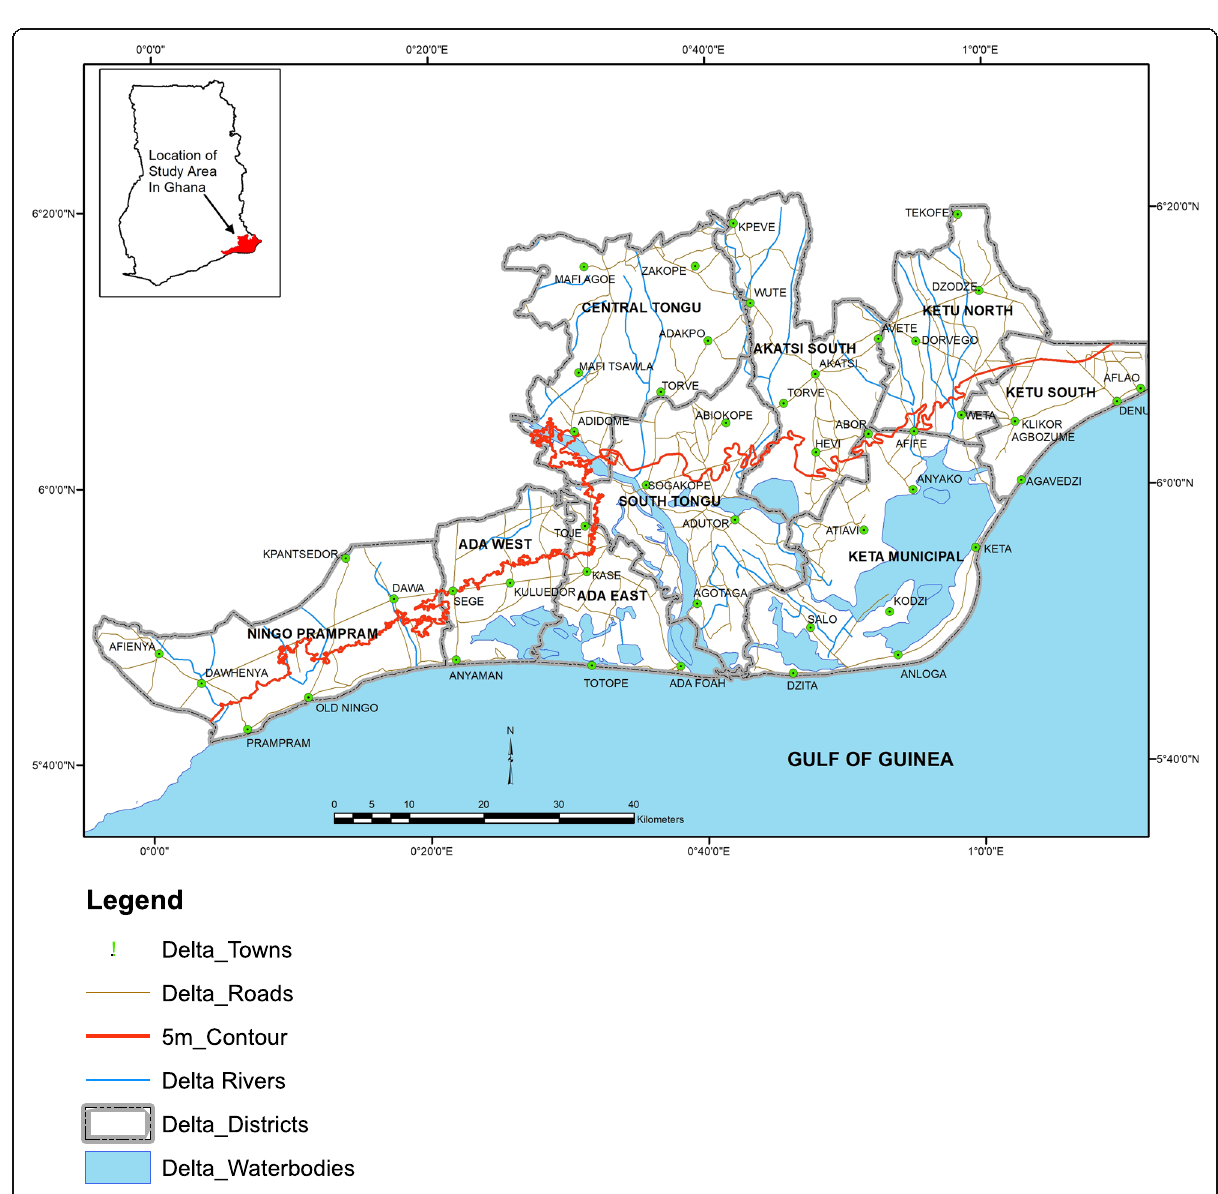
Fig. 1 Map of the Volta Delta Region in Ghana showing the administration districts, the 5 m contour and Fuvemeh (adapted and modified from Appeaning Addo et al.